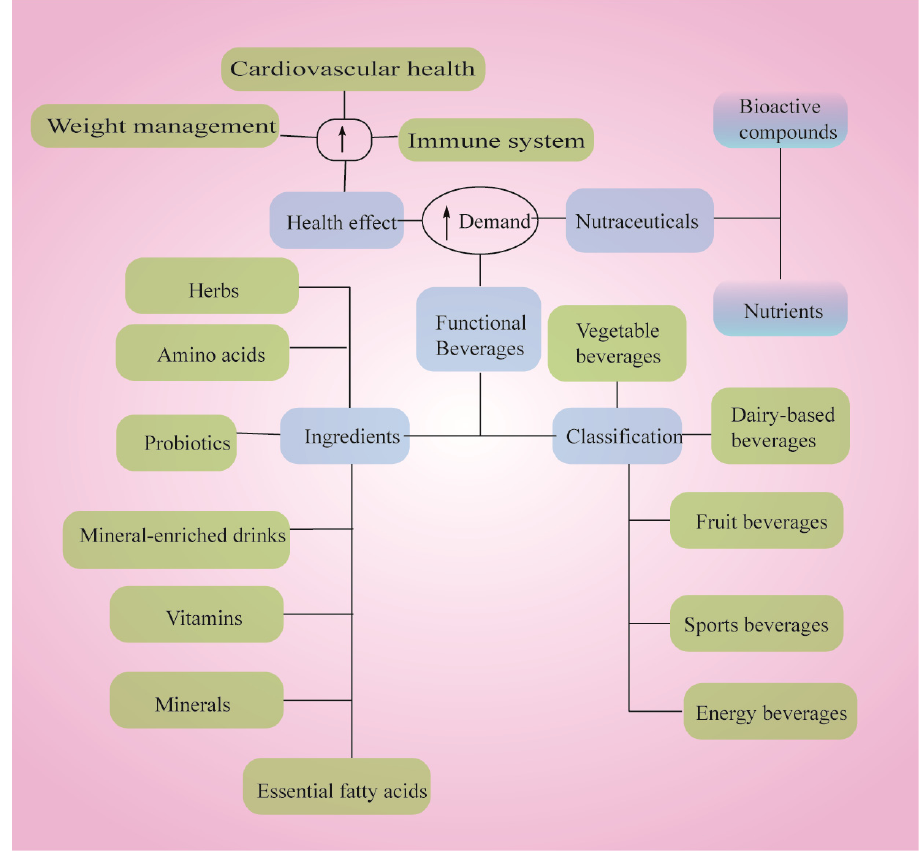
Figure 1. Scheme of functional beverages.